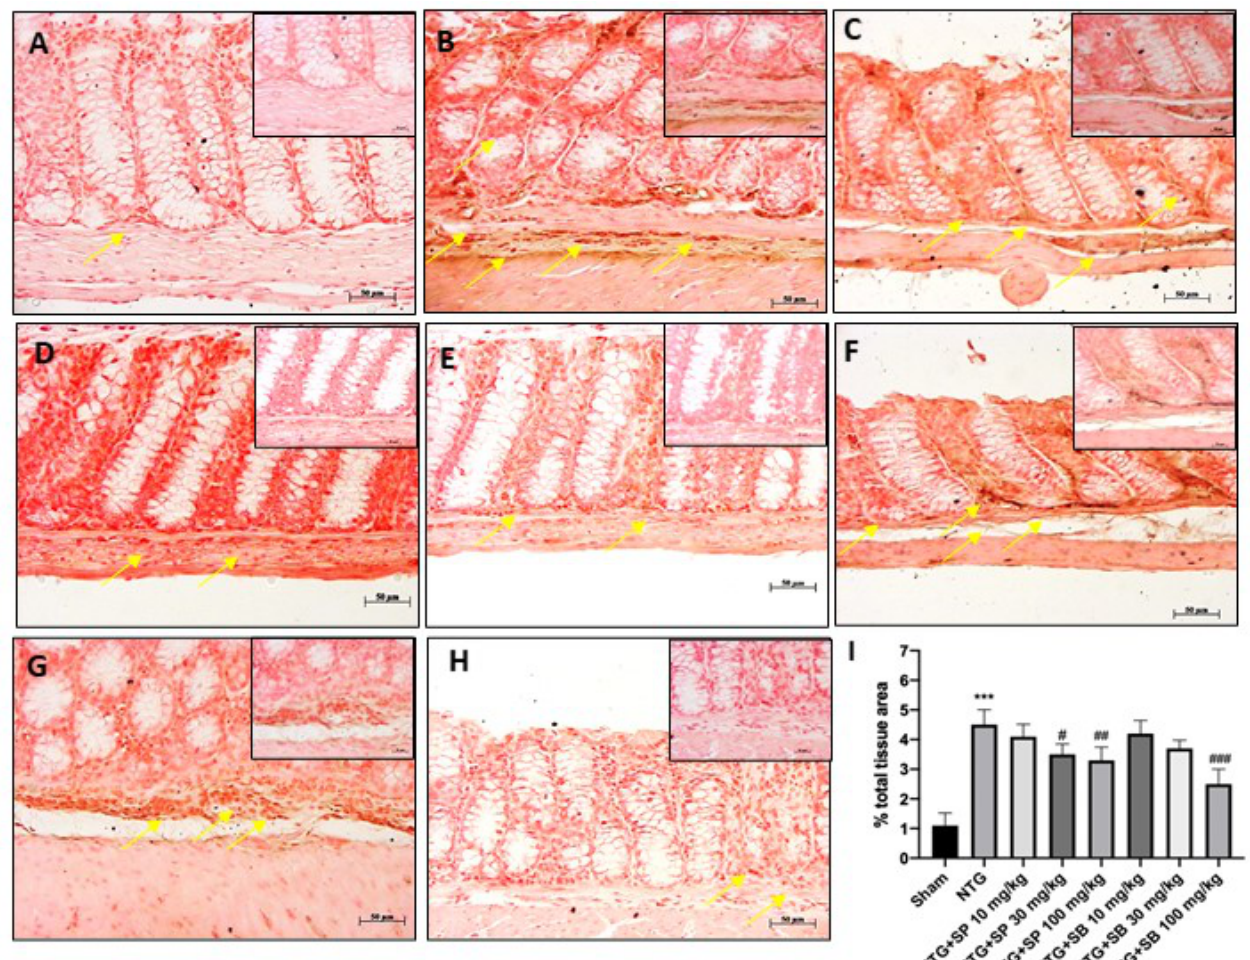
Figure 3. SCFAs treatment decreased ICAM expression. Immunohistochemical localization revealed that NTG group ( B ) was characterized by high expression of ICAM compared to sham group ( A ) however, SCFA treatment ( D , E , G , H ) significantly decreased ICAM expression. No significant difference was revealed in mice treated with 10 mg/kg of SCFAs ( C , F ). The yellow arrows indicated positive cells. ( I ) *** p < 0.001 vs. sham; # p < 0.05 vs. NTG; ## p < 0.01 vs. NTG; ### p < 0.001 vs. NTG.